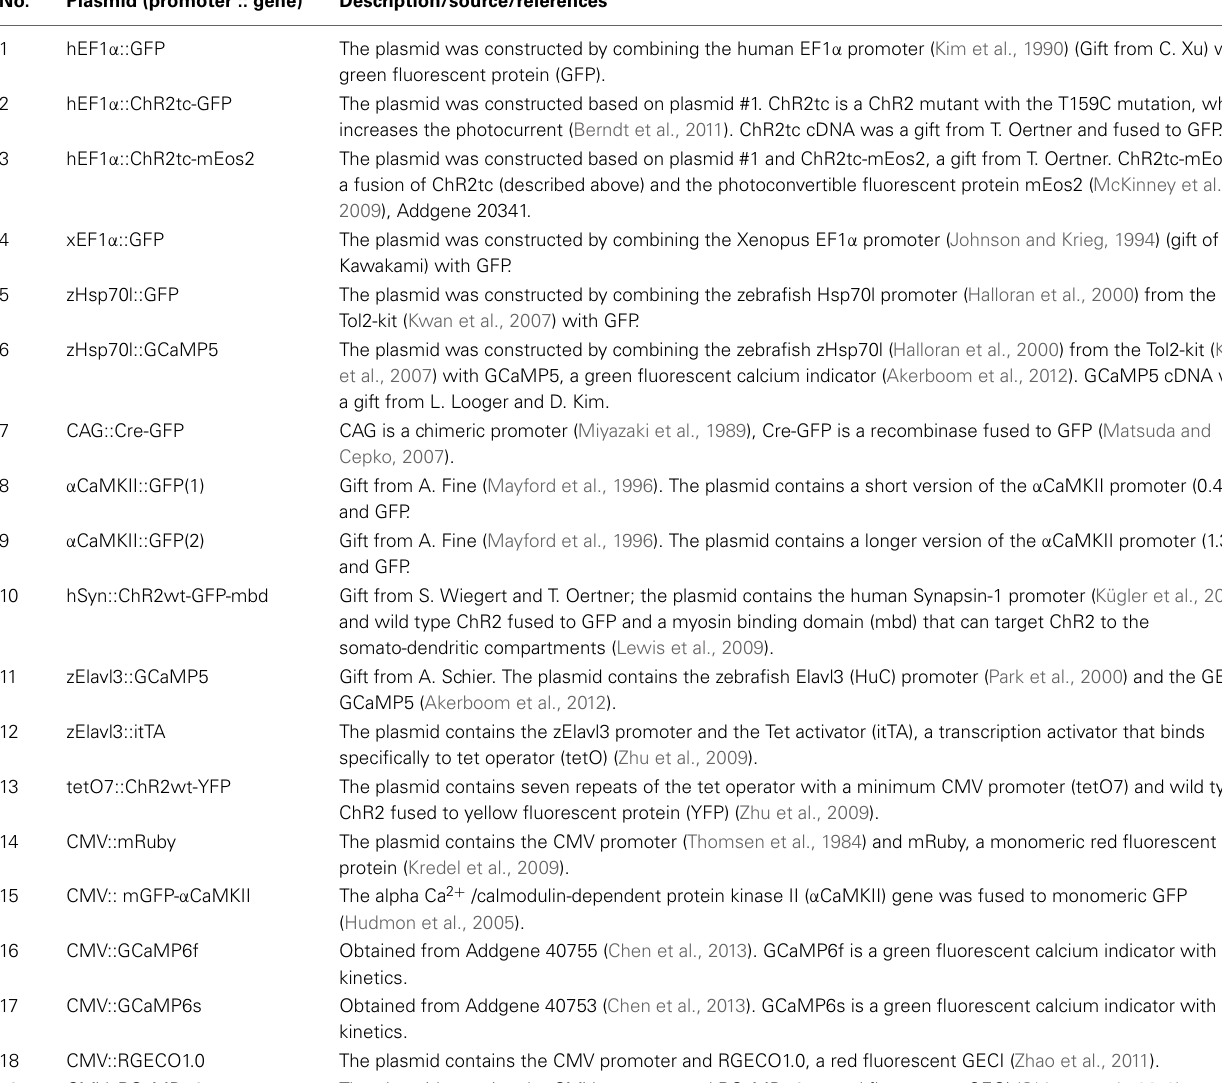
Table 2 | Plasmids used for